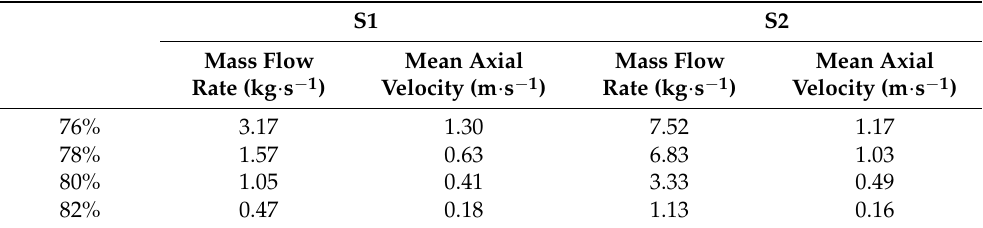
Table 3. Flow rate measured by